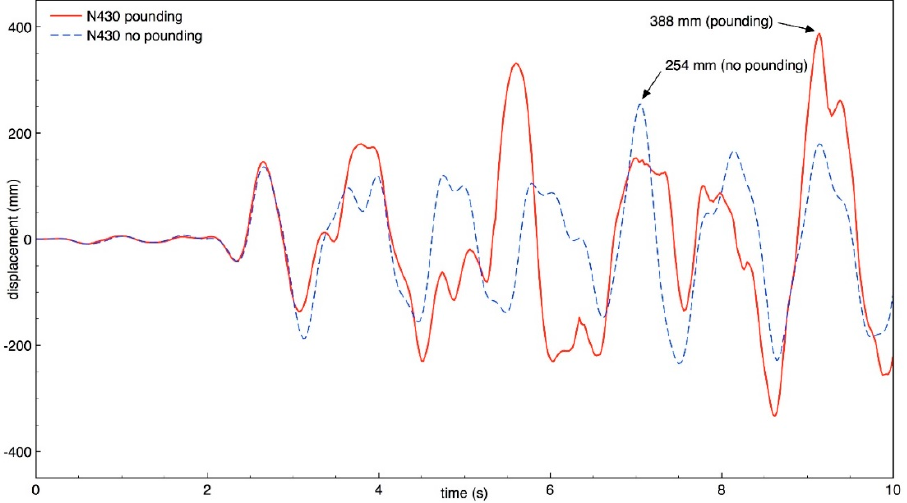
Figure 25. Transverse response of building B (node N430) with and without pounding.